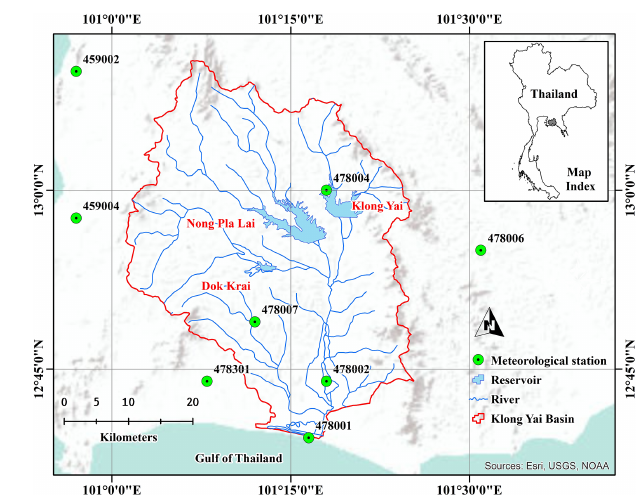
Figure 1. Location of the Klong Yai River basin in